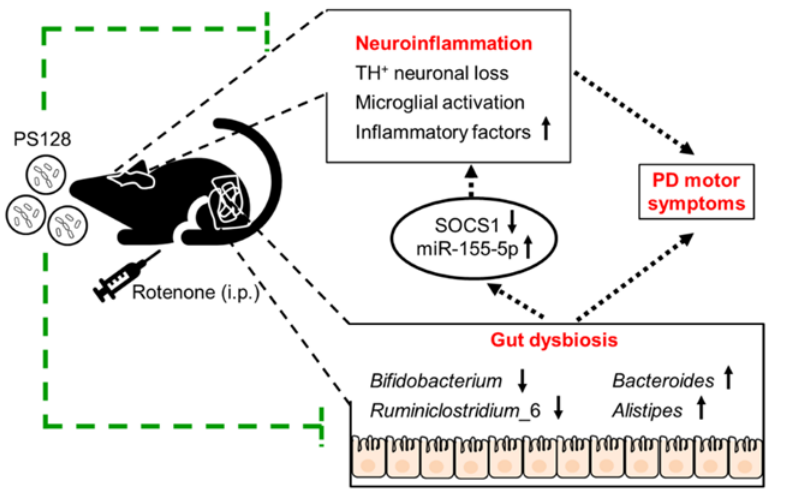
Figure 6. The potential mechanism by which L. plantarum PS128 alleviates motor symptoms in rotenone-induced PD-like mice.